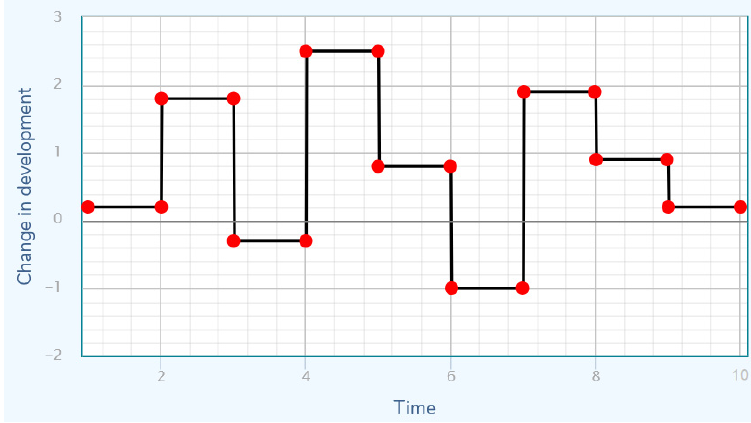
Fig. 2. Entropy (cid:1)(cid:1)(cid:1) the linear approximation of the derivative of development of a